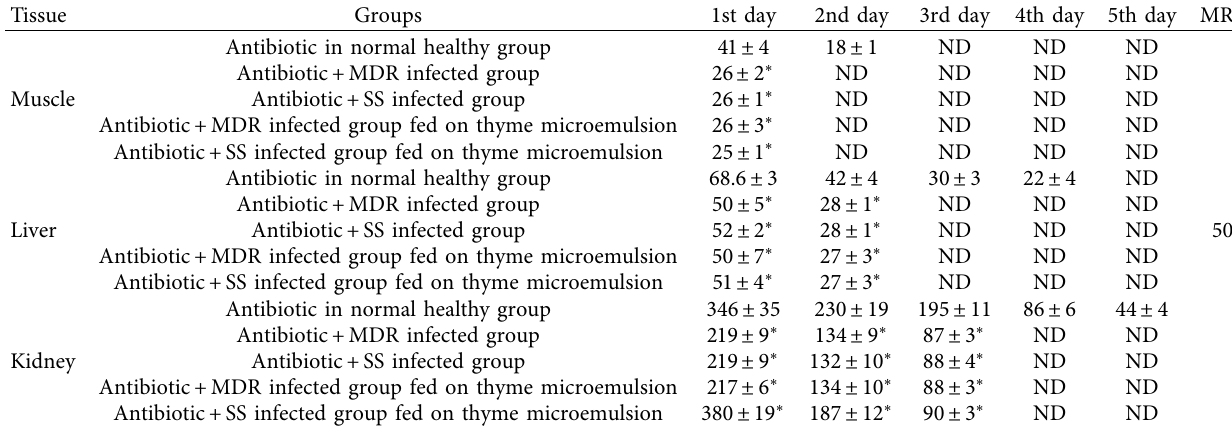
Table 8: Results of trimethoprim concentrations ( μ g/gm) in different boiler tissues after administration of 6.67mg/kg b.wt. for 5 days. Tissue